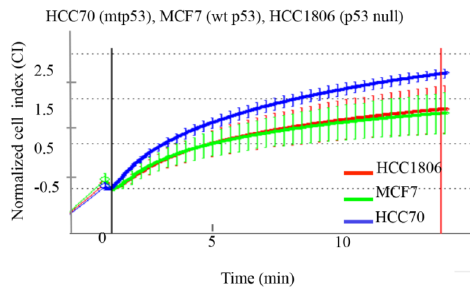
Figure 2. Expression of mtp53 in the HCC70 cell line is associated with increase cell deformability compared to cell lines with wt or no p53. Average variations of the impedance (CI) as a function of time and resulting swelling are shown. Mtp53-expressing cell lines (HCC70, red), wt p53-expressing cell line (MCF7, green) and no p53-expressing cell line (HCC1806, blue) were measured under hypotonic stress using the xCELLigence system. Cell volume (as Normalized Cell Index) was recorded every 2 s following induction of swelling, as described in materials and methods. The HCC70 cell line (red) showed significantly higher deformability, compared to MCF7 and HCC1806 cell lines (green and blue, respectively). Average values and standard deviation at each time points are shown ( n = 4). The first vertical line indicates the addition of water. The second vertical line (shown in red) was used to generate slopes of the curves (data not shown).